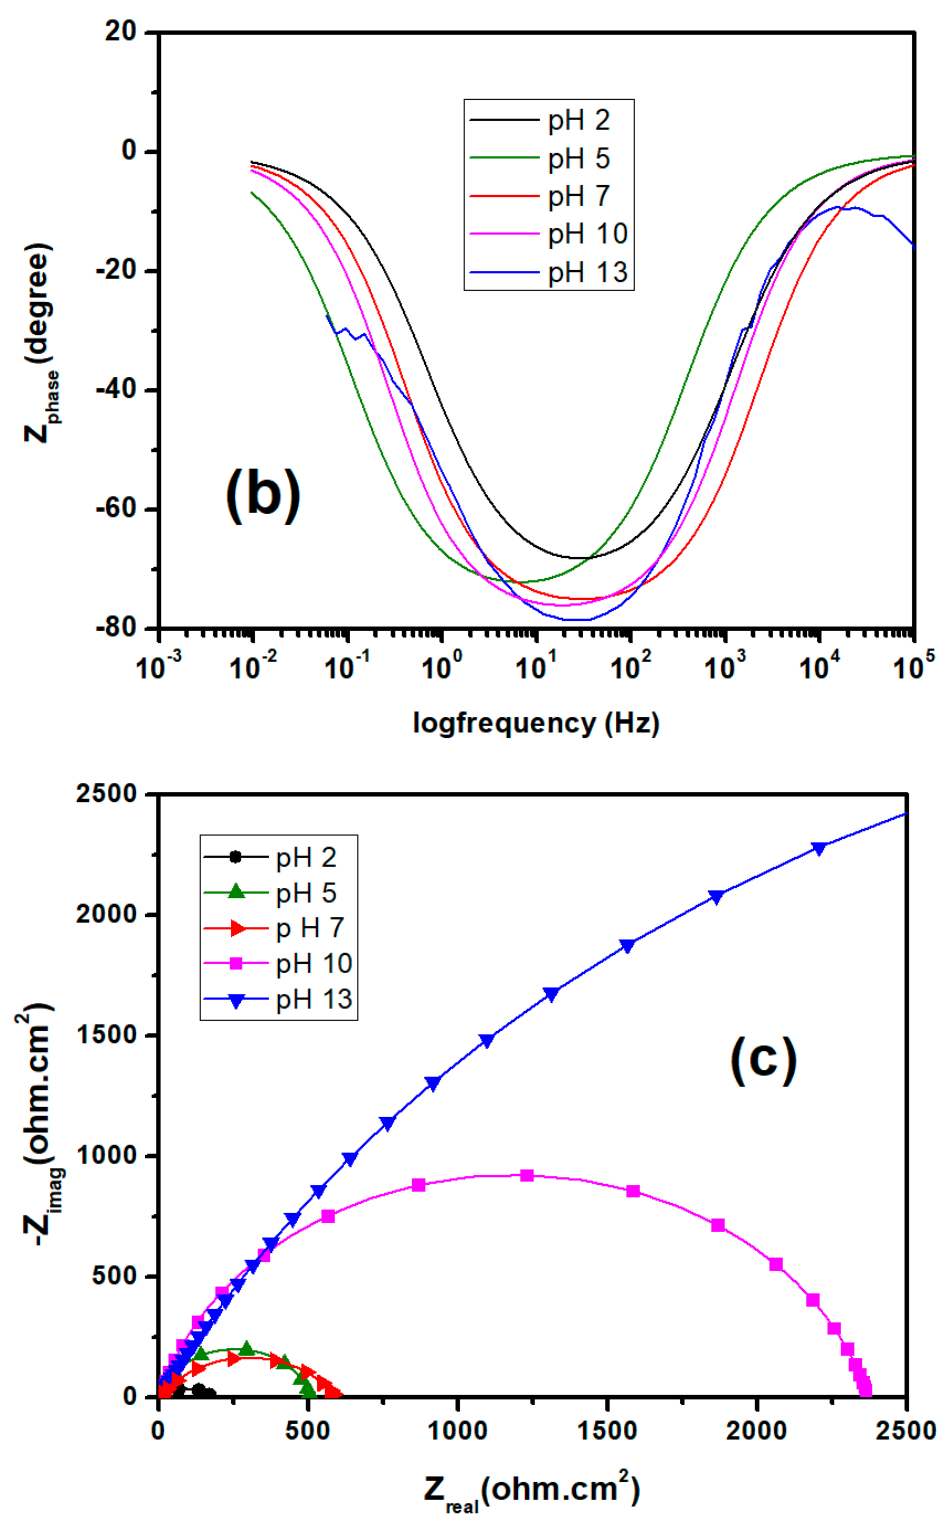
Figure 3. Bode ( a ) phase plot, ( b ) mode plot, and ( c ) Nyquist plot of 2205 duplex stainless-steel in different pH solution.